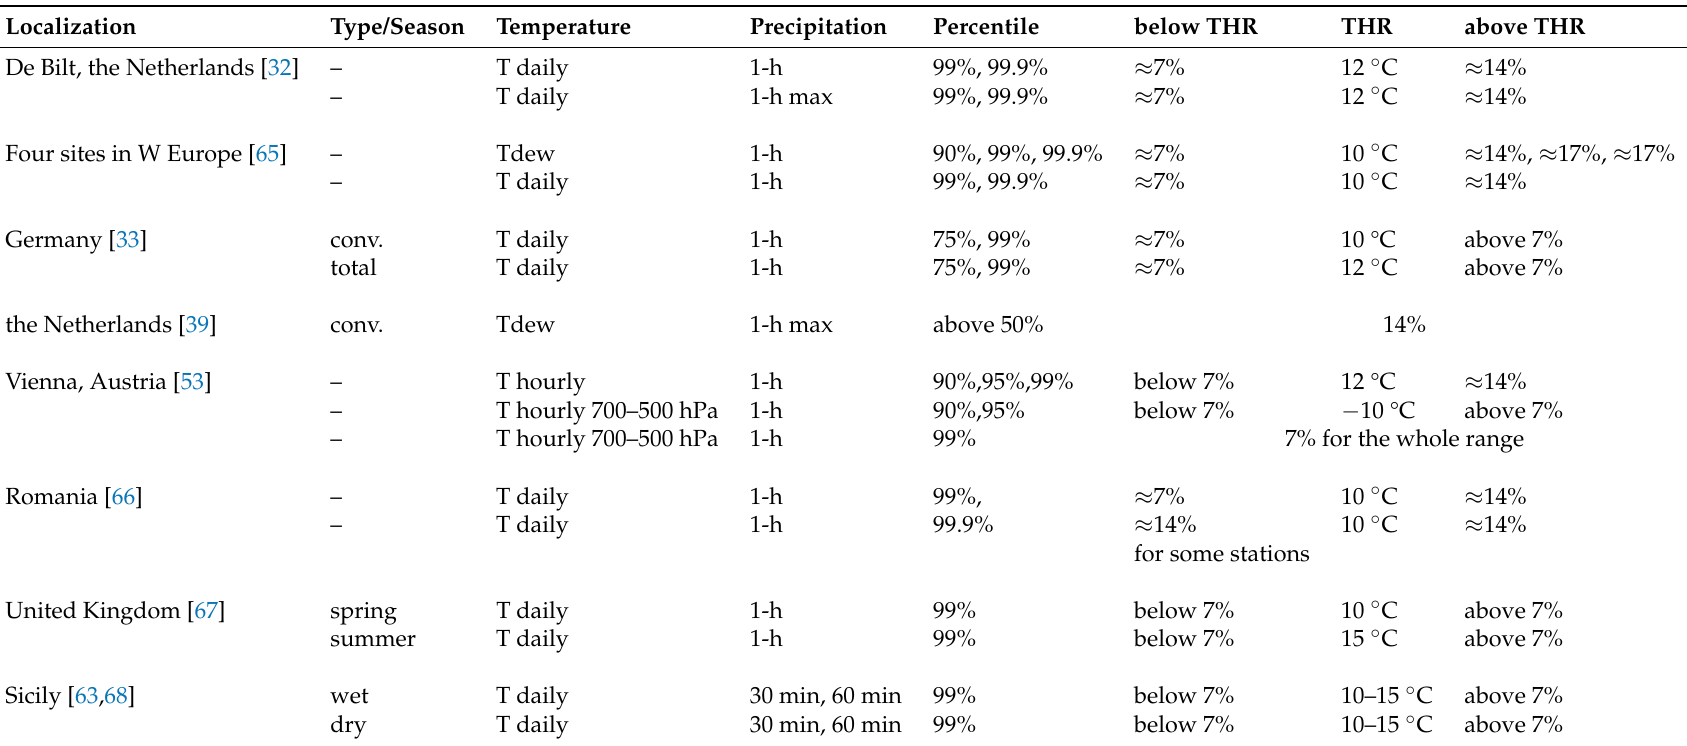
Table 1. Increase of the precipitation-temperature scaling identified by selected observational studies in midlatitudes and corresponding threshold temperature (THR). Where not stated explicitly the results are for the whole year and total